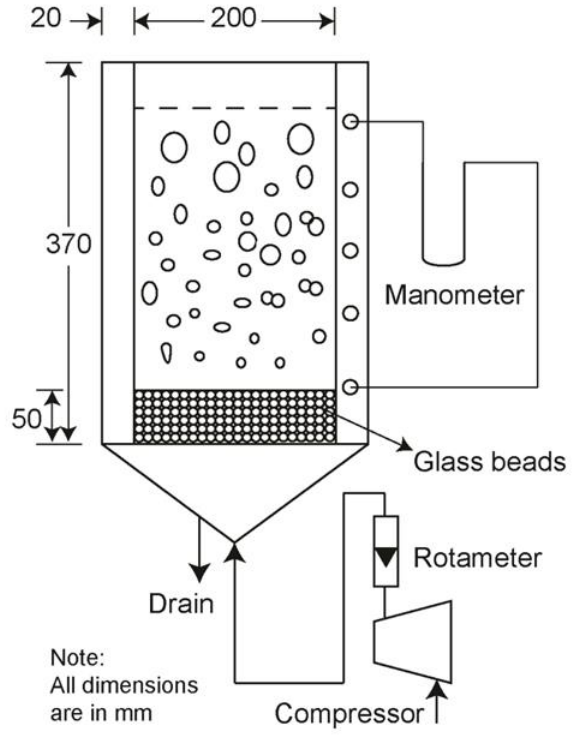
Figure 2. Experimental setup.